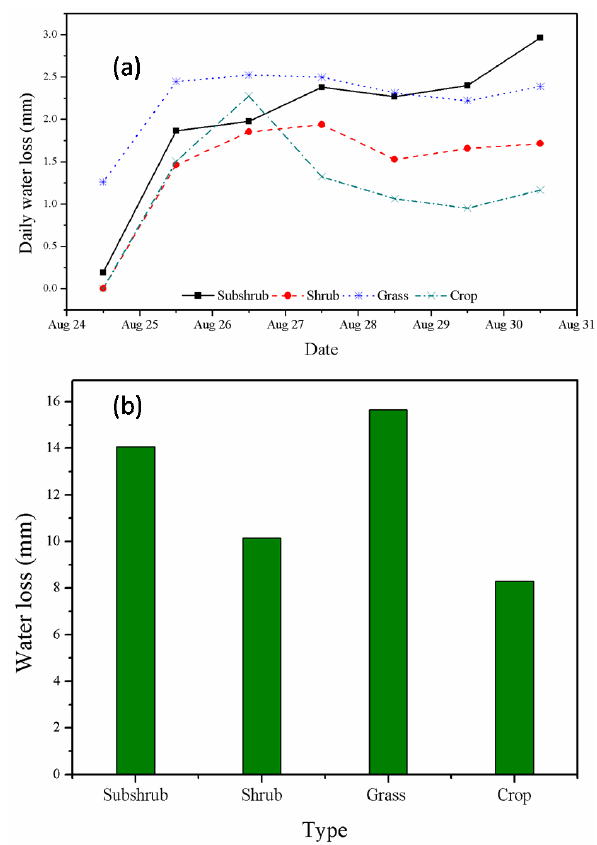
Fig. 9. Daily soil water loss (a) and cumulative water loss (b) under the five land cover types from 25 August to 31